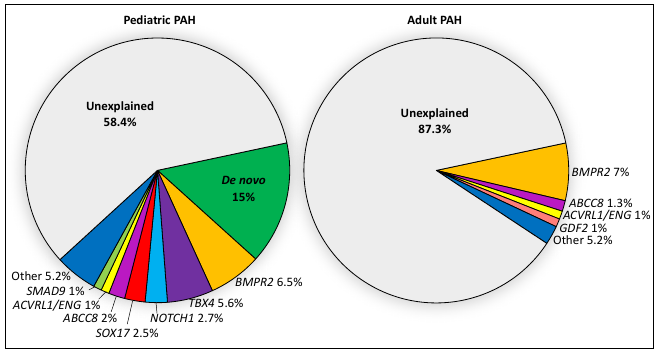
Figure 1. Relative contributions of de novo mutations and 18 PAH risk genes in a cohort of 443 pediatric and 2628 adult cases from CUIMC and the PAH Biobank. Risk genes include BMPR2 , ABCC8 , ACVRL1 , ATP13A3 , BMPR1B , CAV1 , EIF2AK4 , ENG , GDF2 , KCNA5 , KCNK3 , KDR , NOTCH1 , SMAD1 , SMAD4 , SMAD9 , and TBX4 . PAH cases include IPAH, APAH, FPAH and other rarer cases.